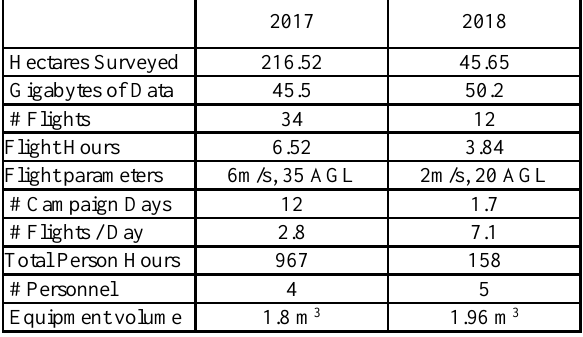
Table 2. Campaign sums for 2017 and 2018. Note: